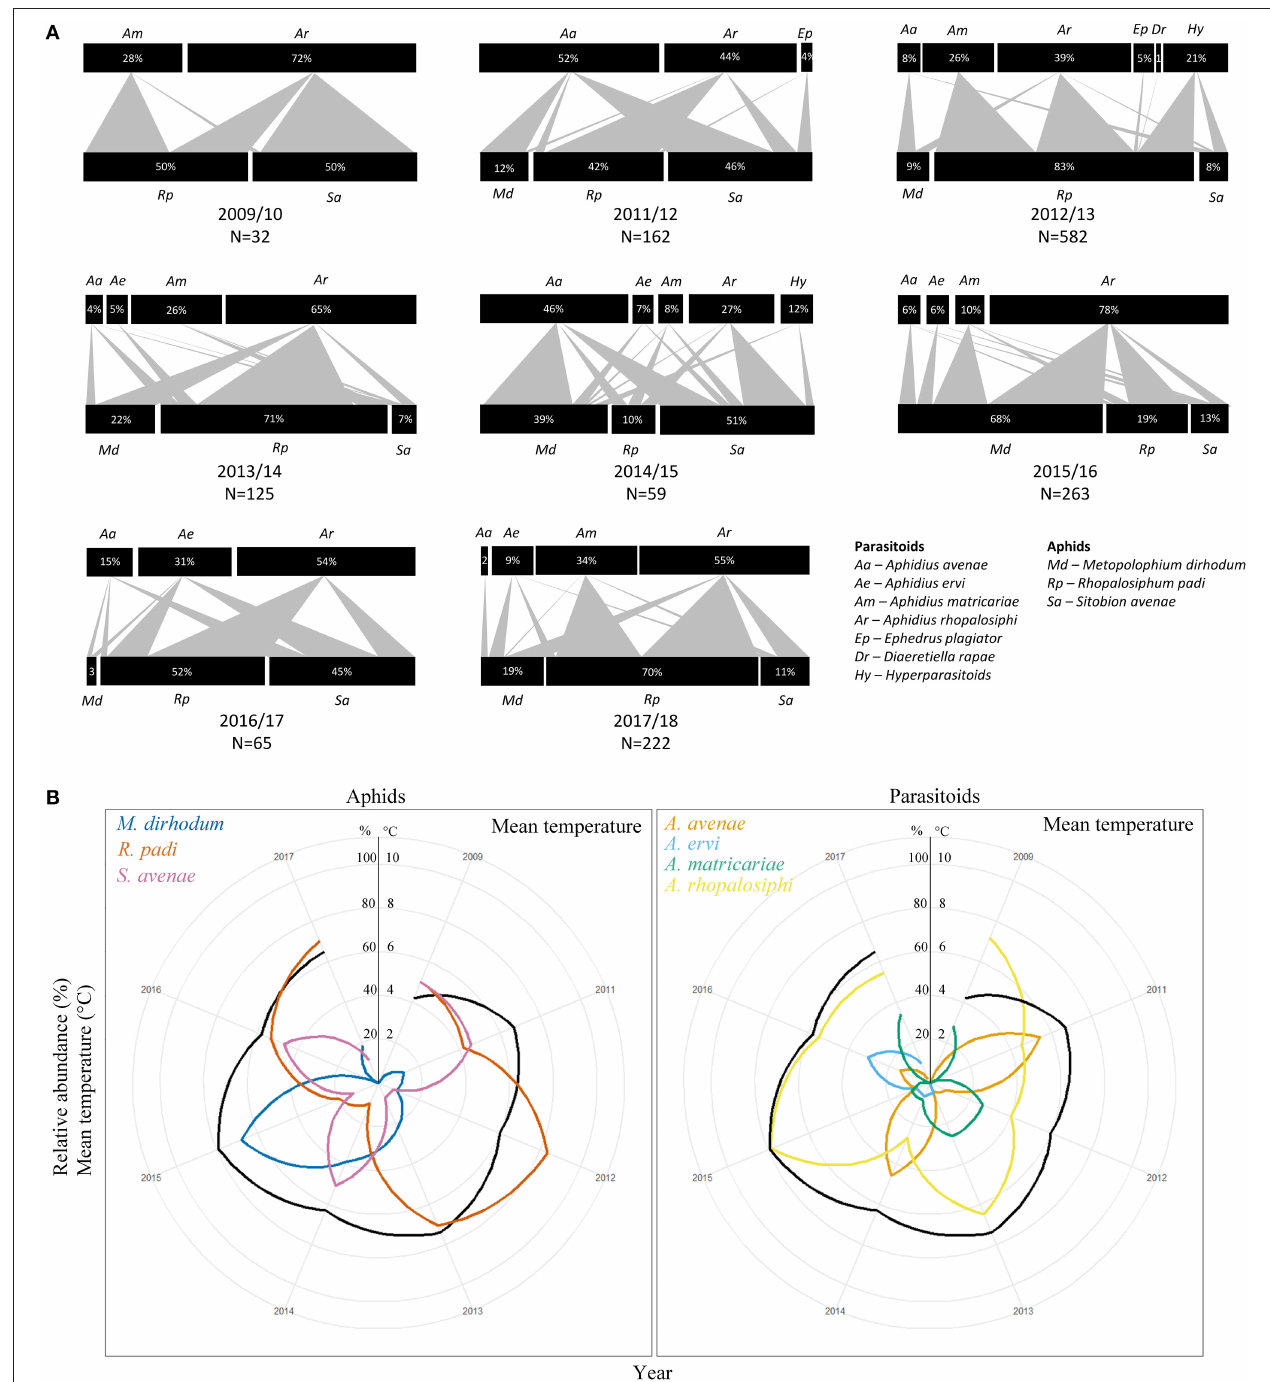
FIGURE 1 | (A) Quantitative food webs of parasitoid and aphid community composition in winters 2009/10 to 2017/18 (there was no insects in 2010/11). Upper and lower bars represent the relative abundance (%) of parasitoid, including hyperparasitoids, and aphid species, respectively. The thickness of the arrow between bars is proportional to the interaction strength between a pair of species. Total number of individuals (N) used to construct each food web is shown for each year. (B) Rankplots showing the relative abundances (%) of aphids (left panel) and Aphidius parasitoids (right panel) each winter from 2009/10 to 2017/18. Mean winter temperature ( ◦ C) is shown in